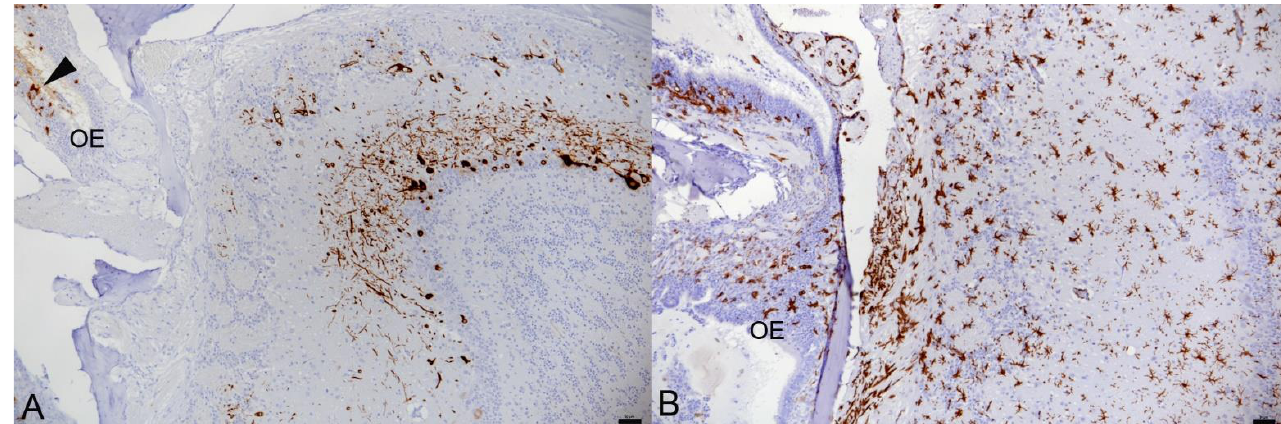
Figure 2. Olfactory bulb, K18-hACE mice, day 5 post-intranasal infection with SARS-CoV-2 Delta variant at 10 3 PFU. Animal with infection of the brain. Consecutive sections showing extensive viral antigen expression in neurons in glomerular, mitral cell and granular cell layer ( A ) and microglial activation as indicated by the morphology and strong Iba1 expression of microglial cells which is strongest in the olfactory nerve layer (arrow) ( B ). The olfactory epithelium (OE) exhibits several infected epithelial cells ( A , arrowhead) and mild macrophage (Iba1+) infiltration ( B ). At day 6, 3 of the 6, Delta variant infected mice exhibited infection of the brain,